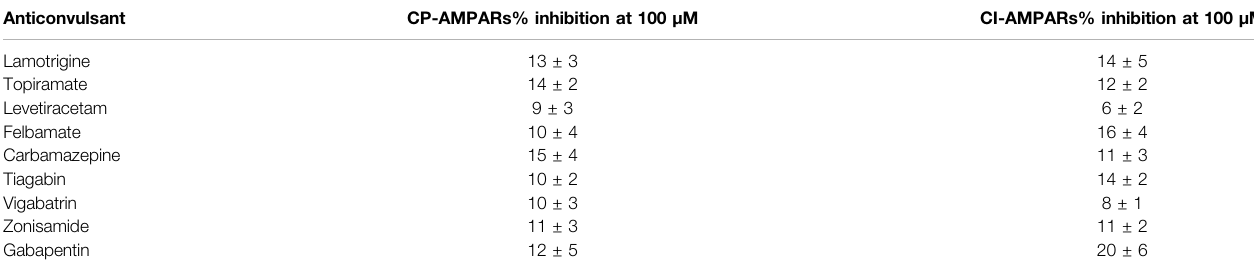
TABLE 1 | Action of anticonvulsants on CP- and CI-AMPARs